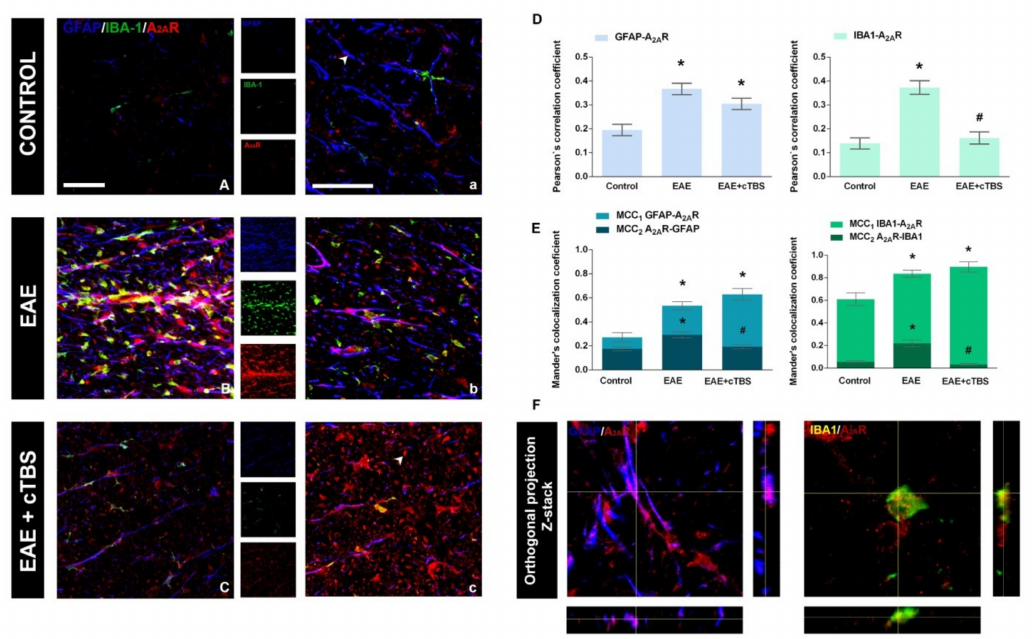
Figure 9. Effects of CTBS treatment on A 2A R expression in lumbar spinal cords of EAE rats. Triple